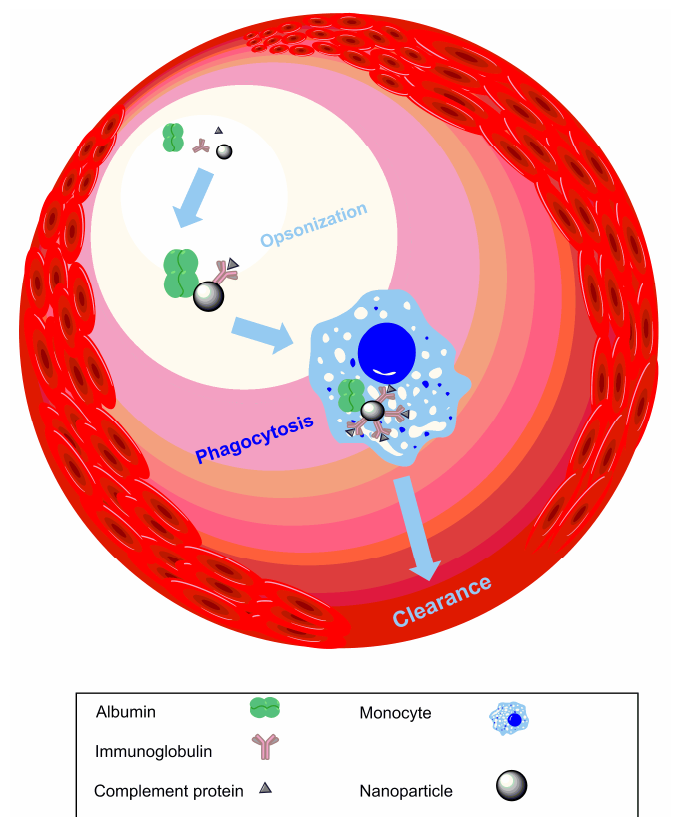
Figure 4. Challenges with NPs: prolonged circulation exposes NPs to opsonisation by albumin, phagocytosis by monocytes, and clearance from the body, thereby reducing their bioavailability and overall therapeutic